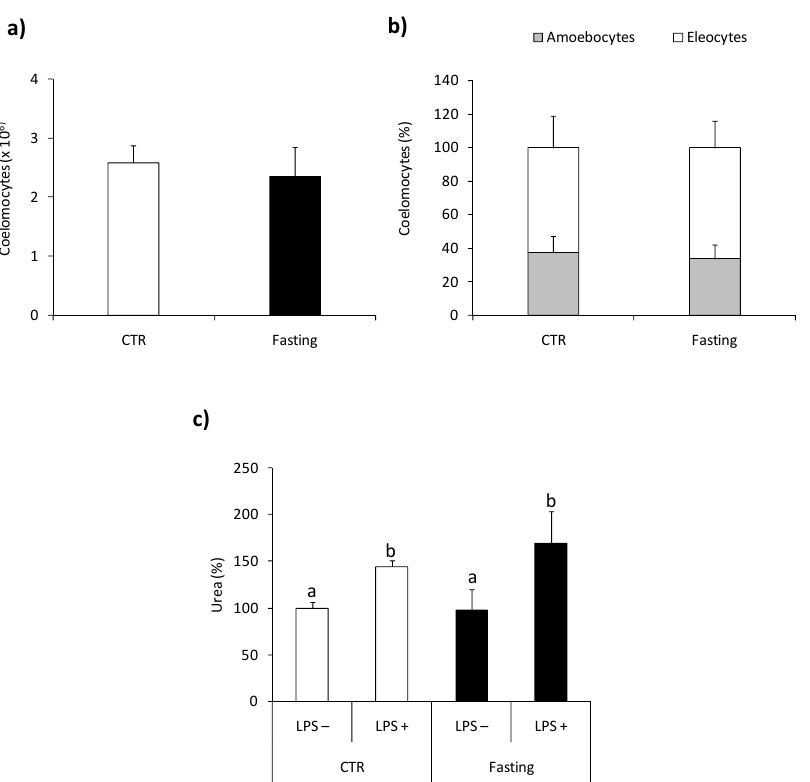
Figure 7. Effects of short-term fasting on arginaseactivity in Eisenia andrei coelomocytes. Coelomo- cytes were collected from earthworms kept in soil (CTR) or exposed for 5 days to filter paper soaked with distilled water (Fasting). The number ( a ) and composition ( b ) of coelomocytes were counted. Arginase activity ( c ) was measured in coelomocytes incubated for 24 h with control medium (LPS–) or with LPS (1 µg/mL, LPS+) and is shown as % of control (arginase activity in LPS-coelomocytes of CTR animals = 100 % ). Mean + SE, n = 10. Mean values that are significantly different are not as- signed a common letter (e.g., a vs. b or b vs. c) according to one-way analysis of variance (ANOVA) (at p < 0.05).